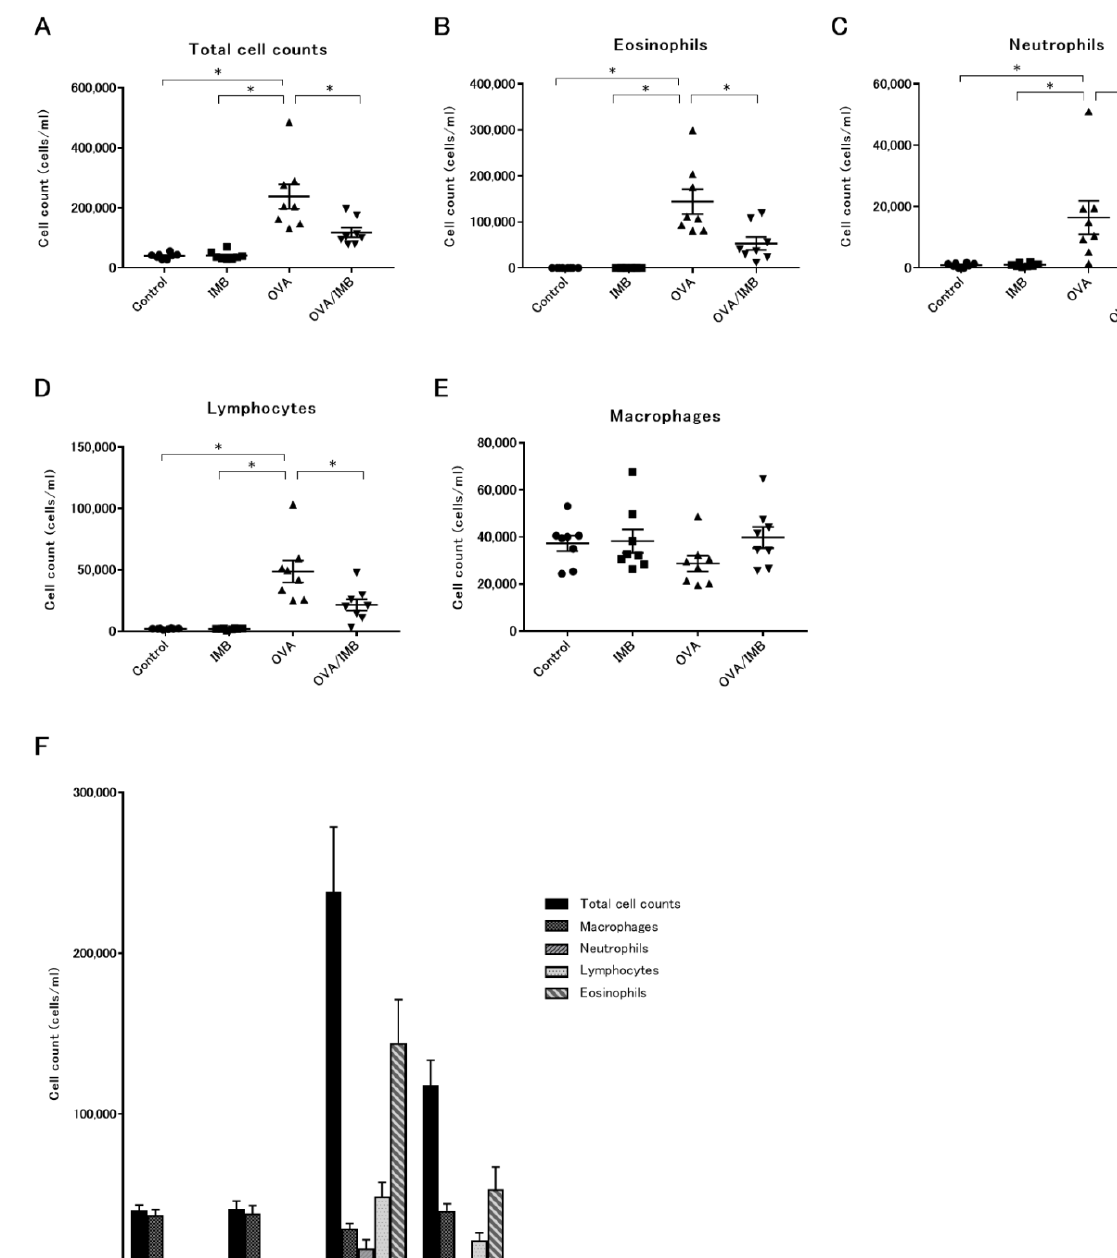
Figure 3. Representative images of BALF from each group are shown at 400× magnification. Scale bar = 50 µm.